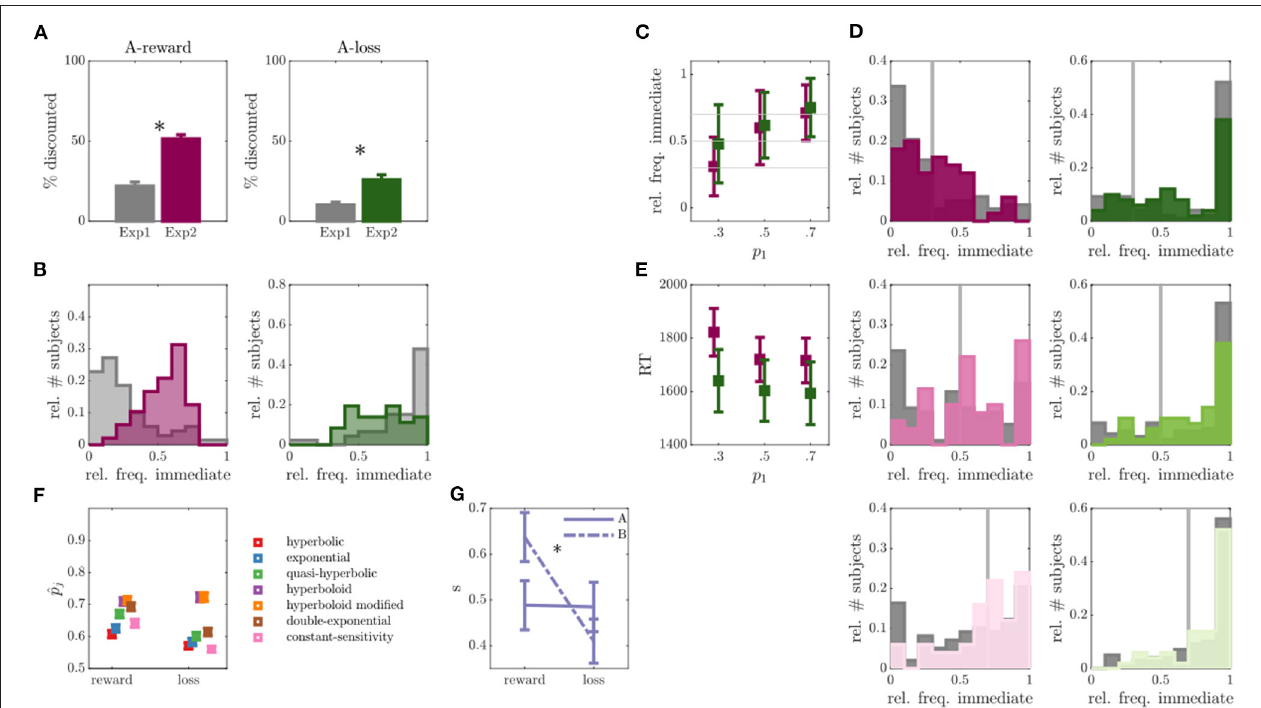
FIGURE 3 | Results of experiment 2. (A) Percentage of discounted choices in run A for experiment (exp) 1 and exp 2 for reward (left) and loss (right) discounting. Asterisks indicate significant differences. (B) Empirical distribution of the relative frequency of immediate choices for reward (left) and loss (right) conditions in run A of exp 1 (gray) and exp 2 (colors). (C) Relative frequency of immediate choices ( y -axis) in run B of exp 2 as a function of experimentally manipulated probabilities ( x -axis) for reward (magenta) and loss (green) conditions (individuals without behavioral variability were removed, N = 2 for reward, N = 14 for loss condition). (D) Empirical distributions of the relative frequency of immediate choices in run B for trials with immediate choice probability 0.3 (top), 0.5 (middle) and 0.7 (bottom), as also indicated by the gray line. Reward condition is displayed left, loss right, exp 1 in gray and exp 2 in color. (E) Average over median reaction times (RT) for the three experimentally manipulated immediate choice probabilities for reward (magenta) and loss (green) conditions. (F) Average predicted (out-of-sample) probability of observed responses ˆ p j ( y -axis) for reward and loss conditions (x-axis) for different models. (G) Inferred scaling parameters s of the modified hyperboloid model for reward and loss discounting